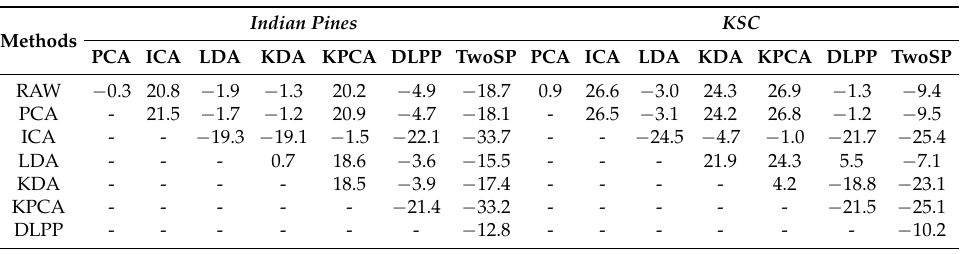
Table 4. McNemar test of different methods on the Indian Pines and KSC datasets.